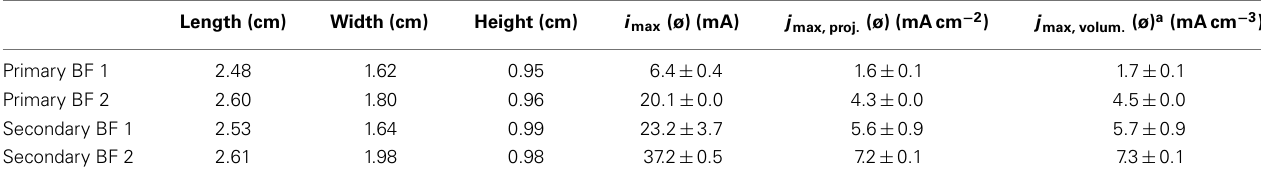
Table 1 | Summary of the geometric dimensions and the performance data of the LCC electrodes used for primary and secondary biofilm experiments